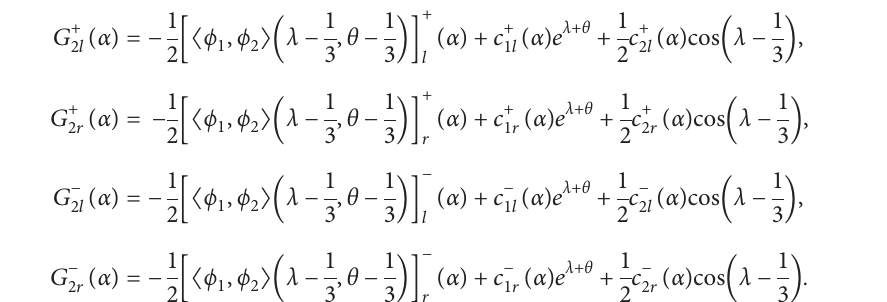
Figure 3: The surface of the intuitionistic fuzzy